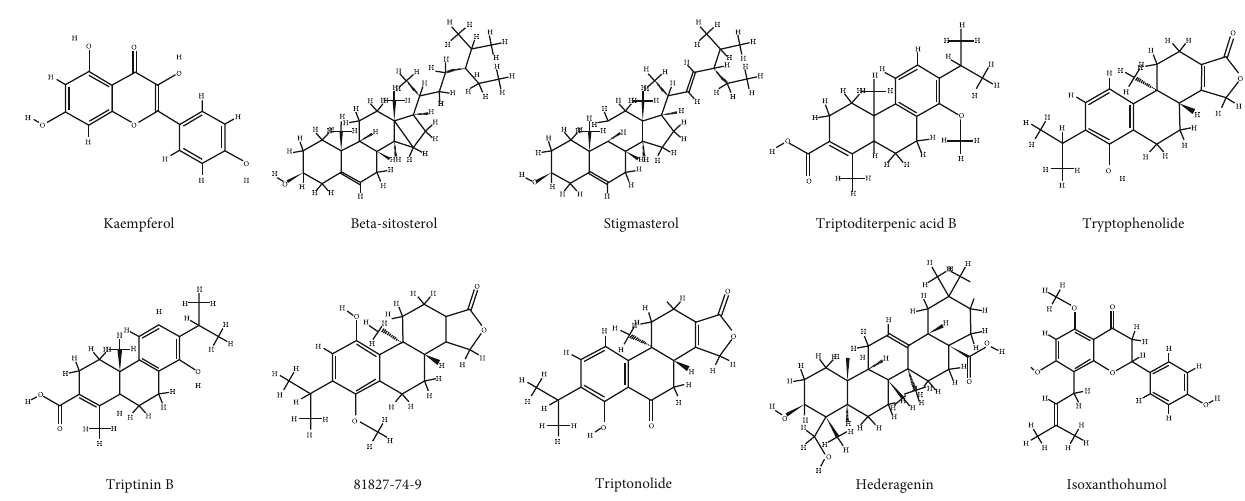
Figure 2: The chemical structure of the ten representative compounds in